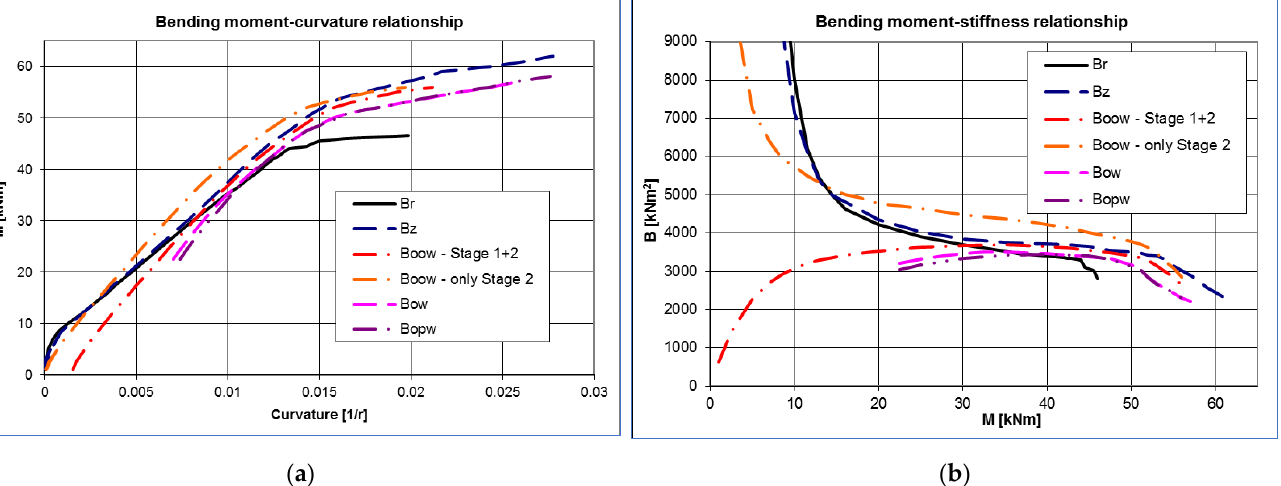
Figure 13. Stiffness analysis based on experimental results. ( a ) Curvature – bending moment diagram at the center of the span of beams; and ( b ) bending moment – stiffness diagram for the cross-section at the midspan of beams.